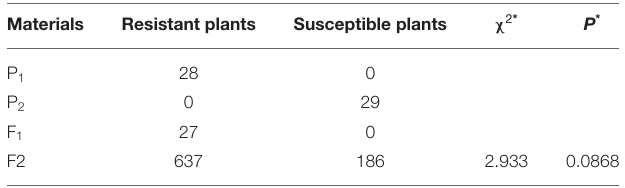
TABLE 1 | Genetic analysis of P 1 , P 2 , F 1 , and F 2 populations inoculated with Pb10 pathotype. Materials Resistant